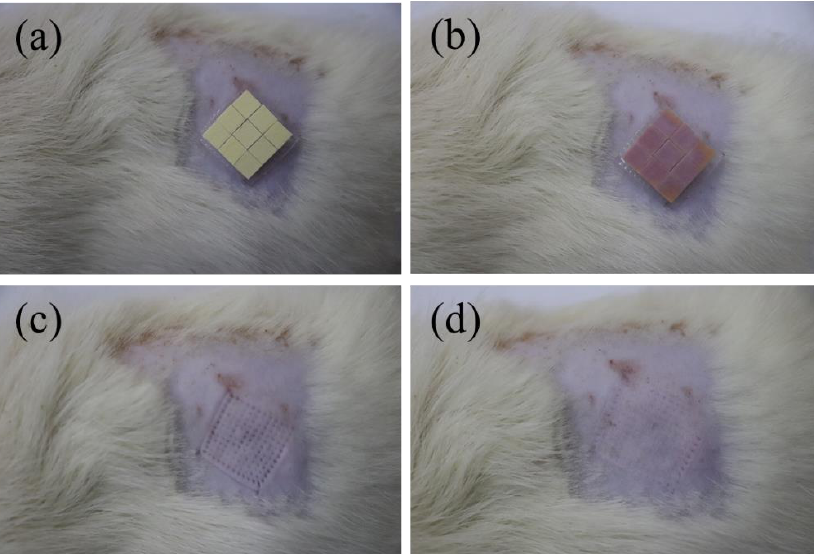
Figure 8. ( a,b ) The rats were shaved on the backs to expose their skin, and the microneedle patch was pressed in with the finger and the color varied after 4 min. ( c ) The microneedle patch was removed to produce the microholes. ( d ) After 30 min, the skin of the rats returned to the original state before the microneedle patch insertion.